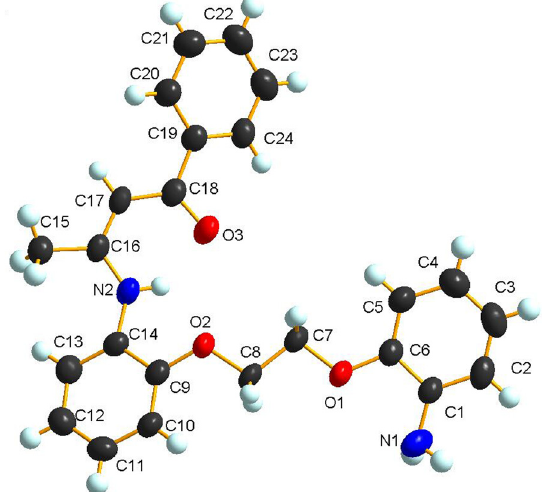
Table  : Data collection and